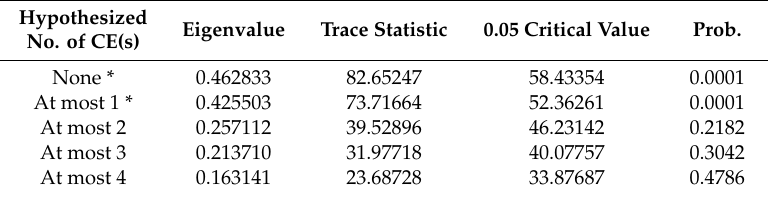
Table 13. Johansen and Juselius cointegration test (maximum eigenvalue).